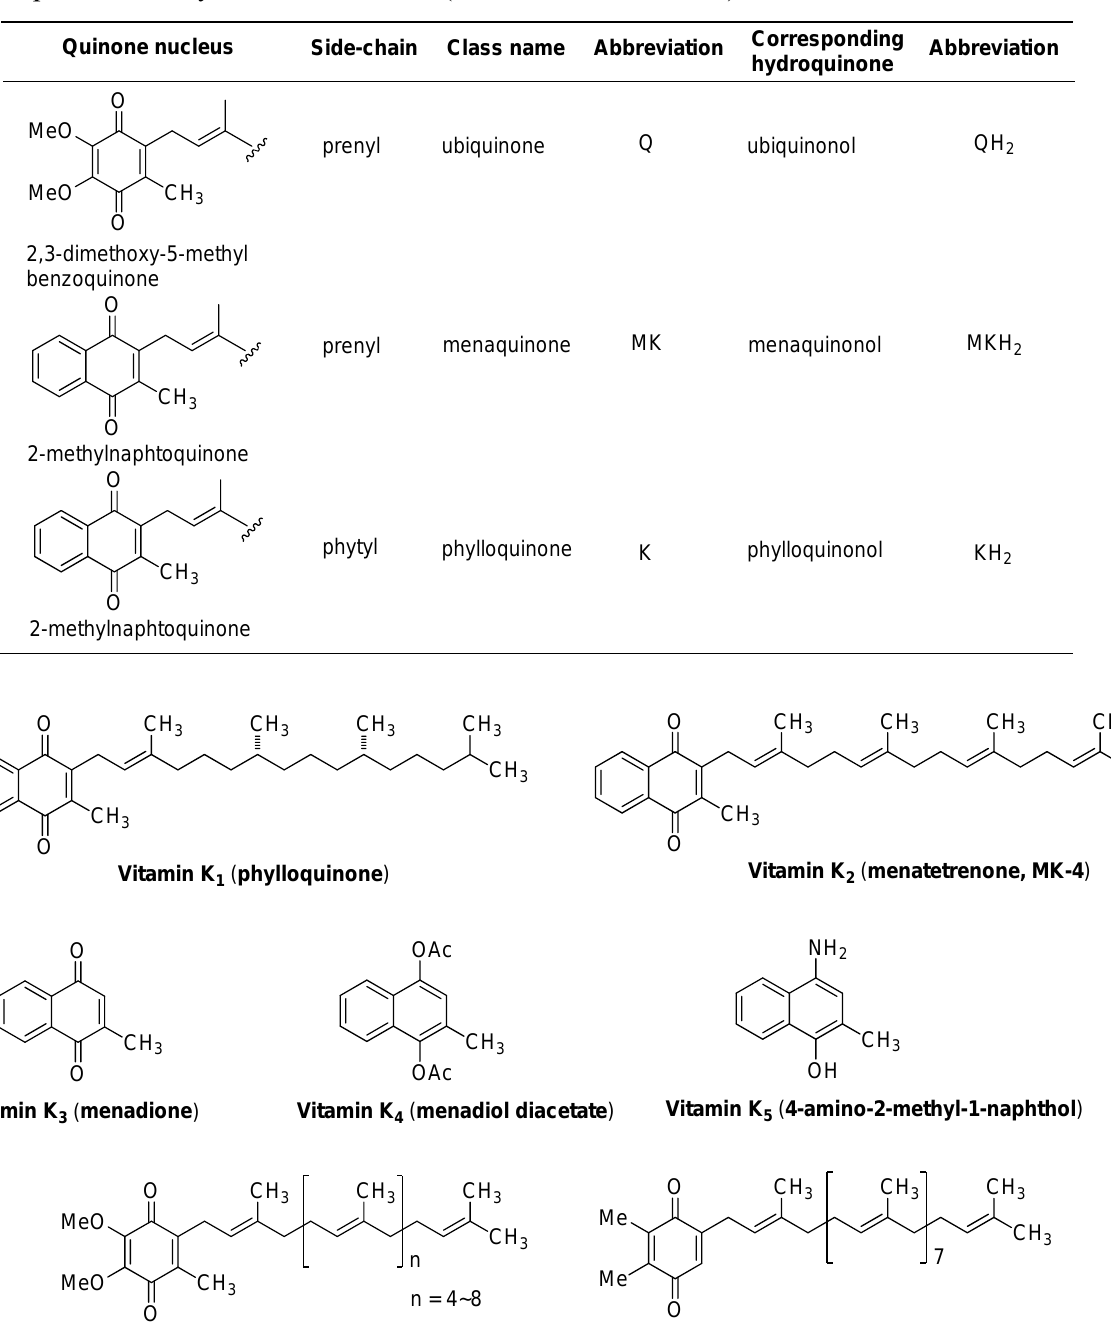
(ubiquinone and plastoquinone) and naphthoquinones (vitamin K representative synthetic vitamin Ks (vitamin K